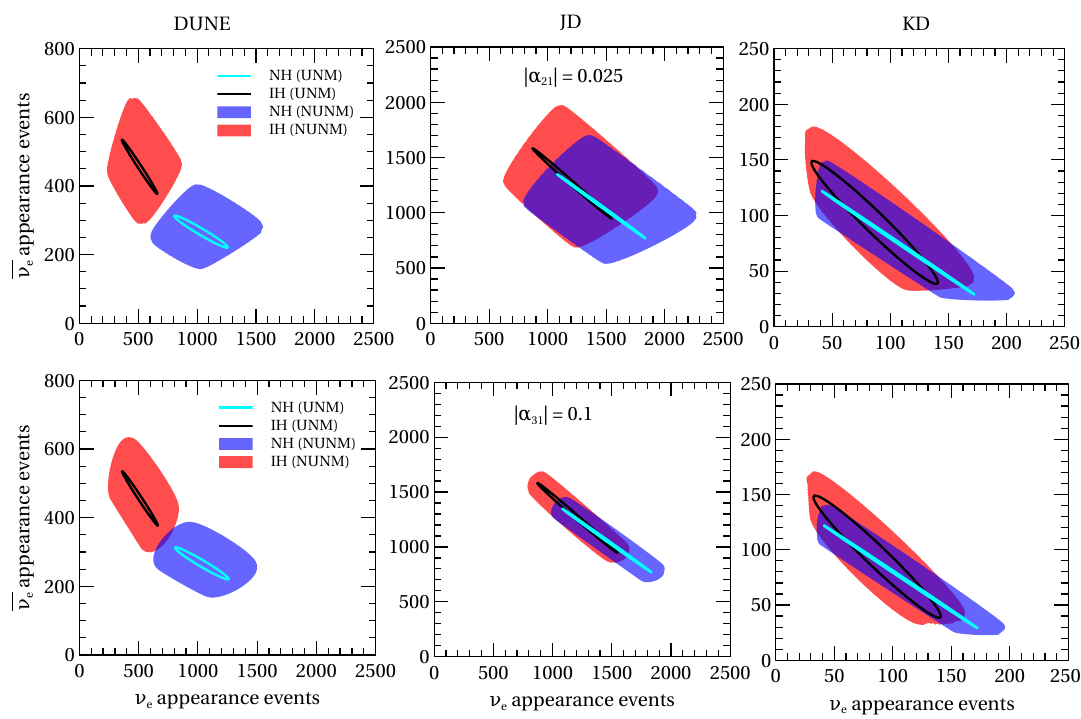
Figure 3 . Bi-event plots for the DUNE (left panel), JD (middle panel), and KD (right panel). The ellipses in each panel are obtained by varying the CP phase δ in the range [ − 180 ◦ , 180 ◦ ] CP assuming α = 0 . The colored blobs in the upper panels show the bi-events in the presence of | α ij 21 | with a strength of 0.025, while the lower panels depict the impacts of | α with a strength of 0.1. 31 | To obtain the blobs with non-zero α , we vary the associated NUNM phases and the CP phase δ ij CP in their allowed range of − 180 ◦ to 180 ◦ . The values of the other standard three-flavor oscillation parameters are taken from table